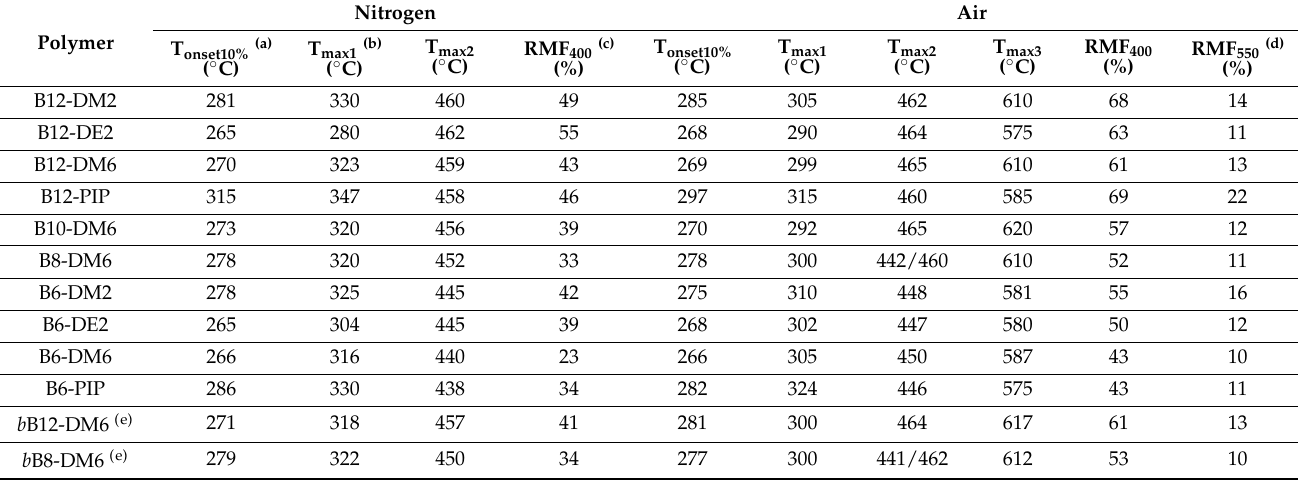
Table 5. Thermal data collected by thermogravimetric analyses